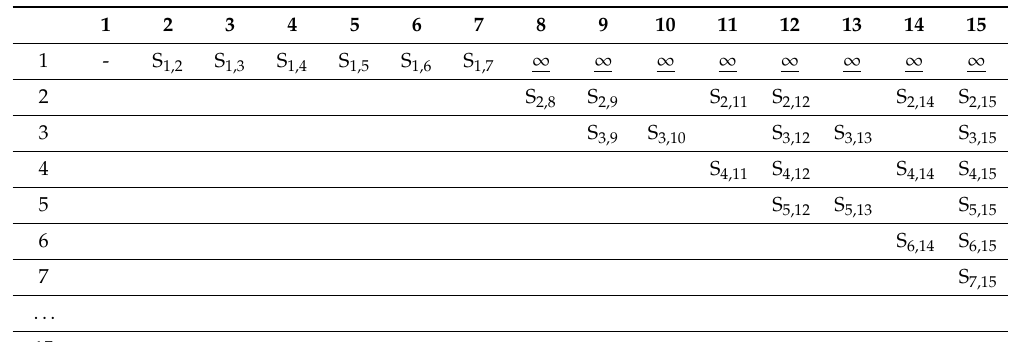
Table 1. Connections matrix from node 1 to node 15. Underline items identify key